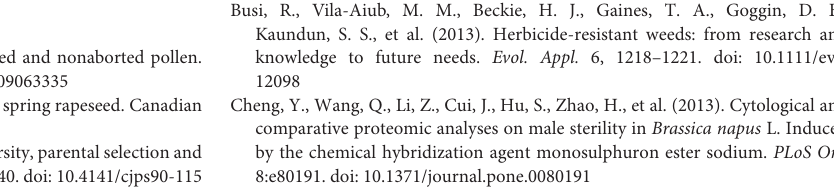
FIGURE S1 | Phenotype of ZS9 treated with different concentration of tribenuron-methly (TBM). (A–E) Morphological observation (upper part) and pollens viability (lower part, bars = 100 µ m) of ZS9 treated with 0, 0.05, 0.10, 1.00, and 2.00 mg · L − 1 TBM. Results showed that 0.10 mg · L − 1 and above TBM treatments could induce pollen abortion in ZS9 , also inhibited growth of plants. See also Tables 2 , 3 . FIGURE S2 | Phenotype of mutant line K5 treated with different concentration of tribenuron-methly (TBM). (A–H) Morphological observation (upper part) and pollens viability (lower part, bars = 100 µ m) of K5 treated with 0, 2.00, 5.00, 10.00, 15.00, 20.00, 30.00, and 40.00 mg · L − 1 TBM. Results showed that 20.00 mg · L − 1 and above TBM treatments could induce pollen abortion in K5 . Also see Table 2 . FIGURE S3 | AHAS activity of leaves and inflorescence of rapeseed ZS9 and mutant line K5 treated with 0 mg · L − 1 tribenuron-methly. Values are the mean ± SD, n = 6. Different lowercase letters means significant difference at p = 0.05 level by Student’s t -test. FIGURE S4 | Phenotypes of wild type Arabidopsis plants 21 days after treated with different concentration of tribenuron-methly (TBM). (A–C) Wild type Arabidopsis plants treated with 0, 0.004, and 0.007 mg · L − 1 TBM, respectively. (D–F) Pollen viability of the plants from (A–C) , respectively. FIGURE S5 | Phenotypes of wild type Arabidopsis seedlings 14 days after treated with tribenuron-methly (TBM). (A) 0 mg · L − 1 TBM; (B) 0.10 mg · L − 1